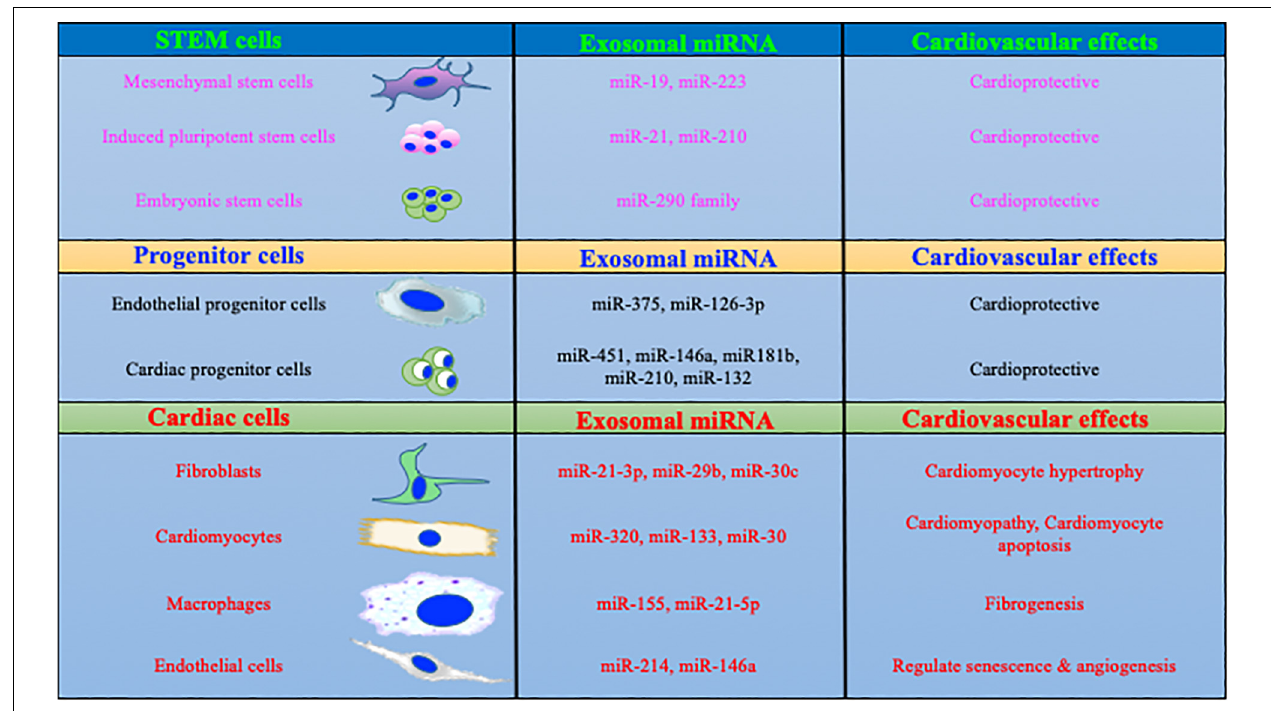
FIGURE 1 | MicroRNAs packaged in exosomes regulate cardiac biology. Exosomal content is dependent on the parent cells and its physiological status. More specifically, exosomes derived from macrophages and fibroblasts are enriched in miRs which are involved with profibrotic and inflammatory signaling. In contrast, stem/progenitor cells derived exosome contains cardio protective